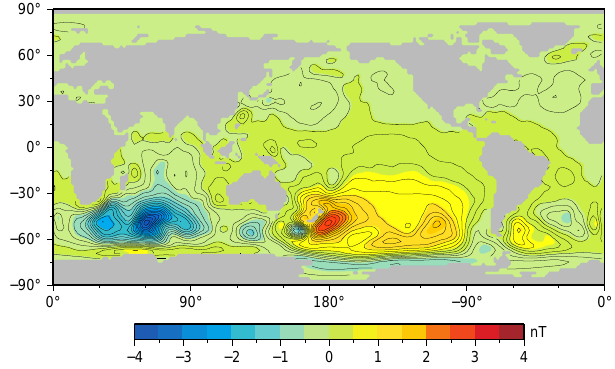
Figure 4. Standard deviation of motionally induced magnetic field at sea level altitude due to ocean global circulation from the constant conductivity experiment in nanoteslas